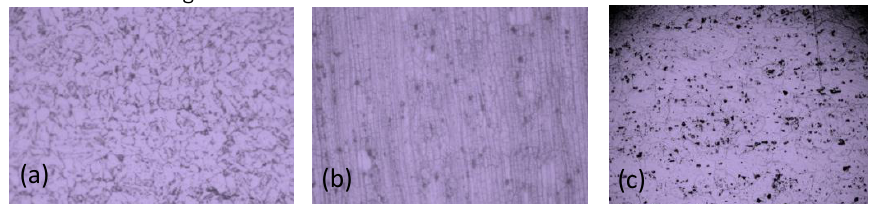
Fig. 1. Optical microscopy of AA5083 Alloy (a) as-received (b) cold rolled (c)